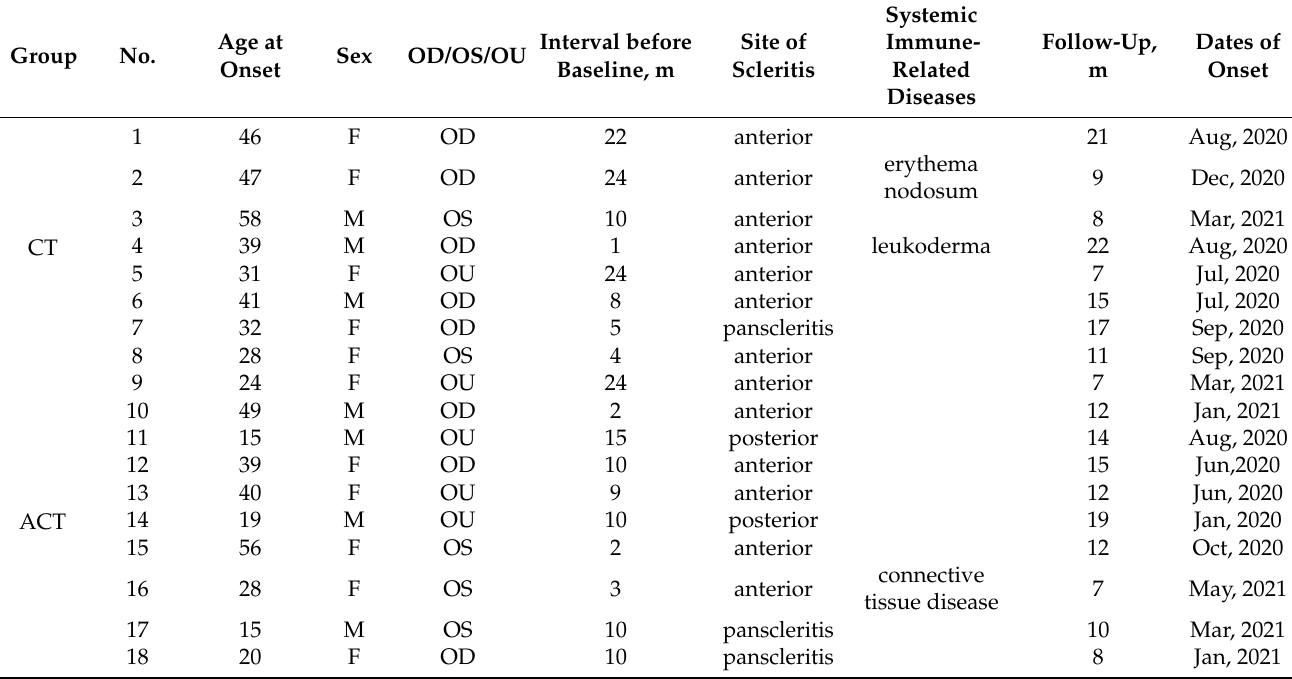
Table A1. Demographics and clinical characteristics of individual patients.